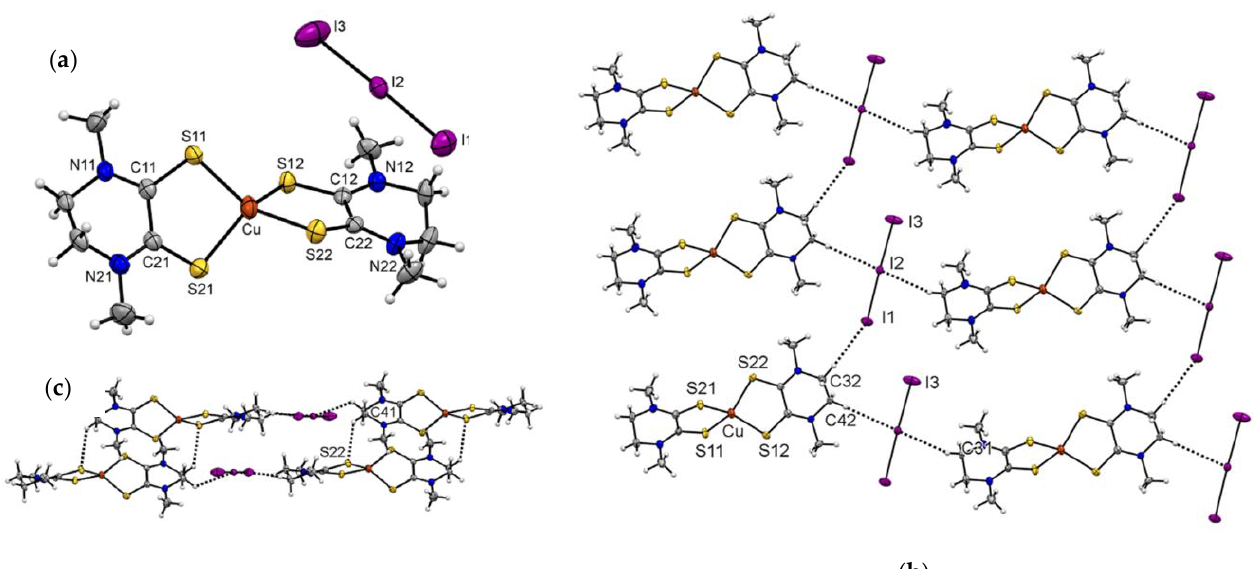
Figure 3. ( a ) Molecular structure of complex [Cu(Me 2 pipdt) 2 ]I 3 ( 3 ) with thermal ellipsoids plotted at the 50% probability level. ( b , c ) Portions of the crystal packing, showing intermolecular interactions as dashed bonds.